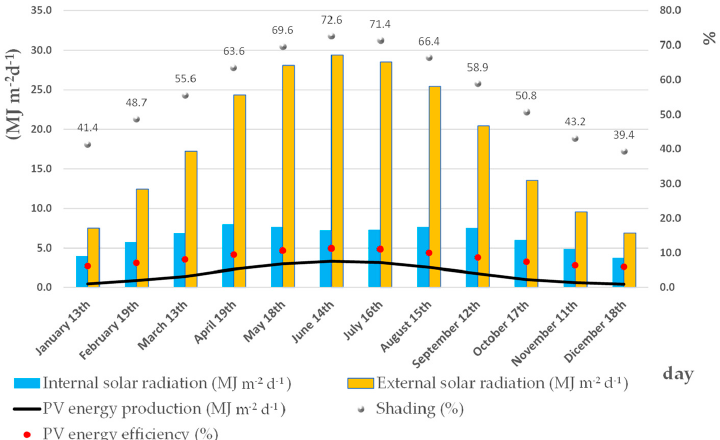
Figure 8. The total available internal solar radiation, the PV energy production and efficiency under different degrees of shading, and the maximum value of the internal solar radiation for the considered days.